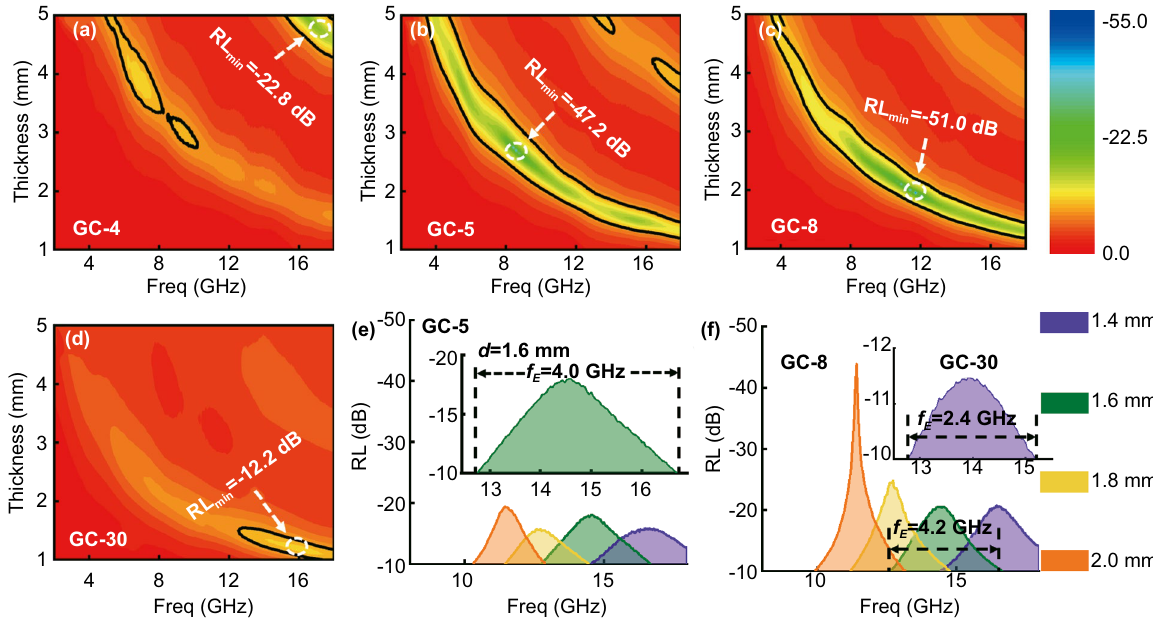
Fig. 5 EM dissipation properties of GCs. a – d 2D colored reflection loss (RL) values of GC-4, GC-5, GC-8, and GC-30. e f E curves of GC-5 with thickness < 2.0 mm. Inset shows the RL curve with the broadest f E of GC-5. f f E curves of GC-8 and (inset) GC-30 with thickness < 2.0